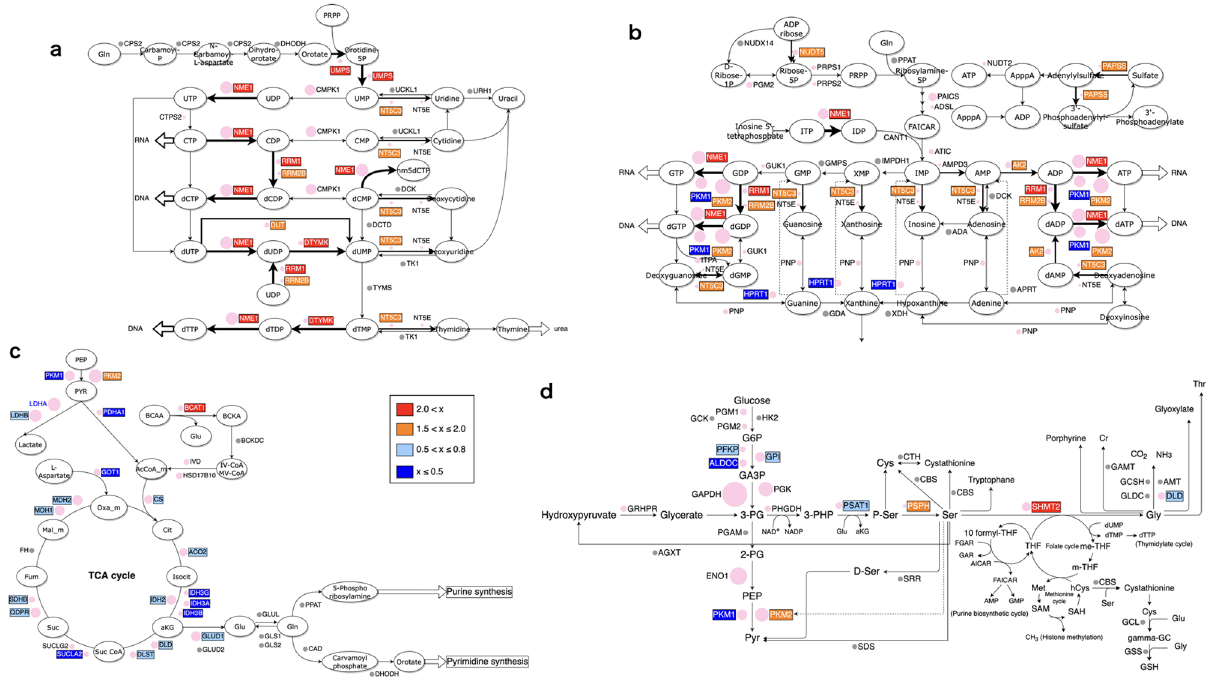
Figure 4. iMPAQT-determined changes in the abundance of enzymes. The size of each pink circle represents the abundance of the indicated enzyme. Grey circle means the abundance of the enzyme is either not detectable or not measured. The fold change is Positive vs Negative. ( a ) Pyrimidine synthesis pathway. ( b ) Purine synthesis pathway. ( c ) TCA cycle. ( d ) Serine synthesis pathway.